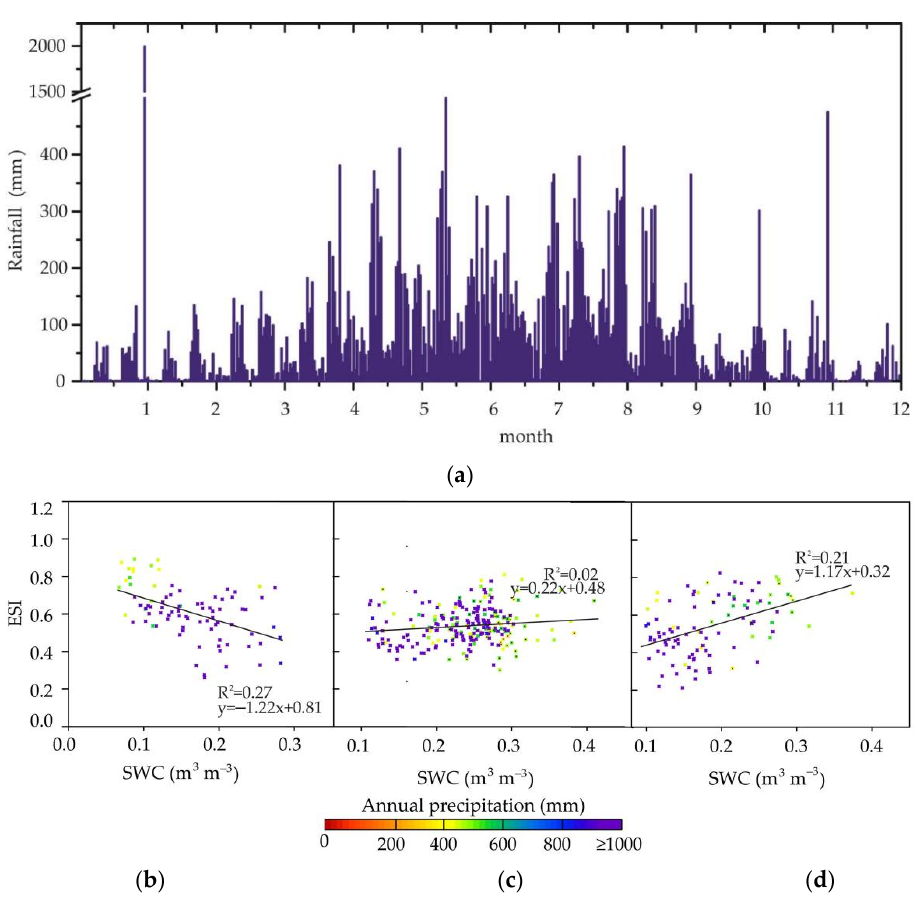
Figure 10. Variation of ESI with SWC in different periods at the DHS, QYZ and XSBN stations with the annual precipitation exceeds 800 mm. ( a ) is the time series of average precipitation of the DHS, QYZ and XSBN stations; ( b ) is the correlation between ESI and SWC from January to March; ( c ) is the correlation between ESI and SWC from April to September; and ( d ) is the correlation between ESI and SWC from October to December.